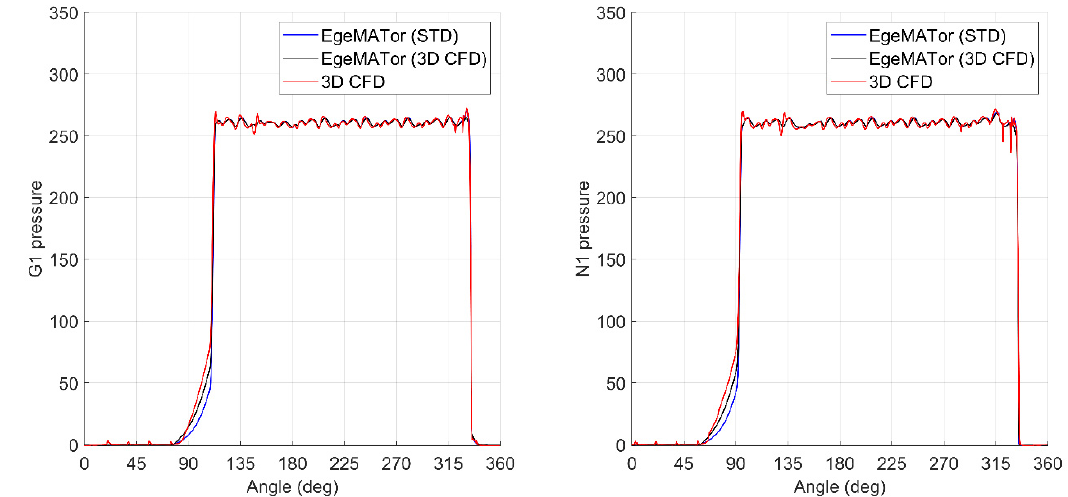
Figure A2. Gi and Ni pressure distributions for a 10-teeth EGP.